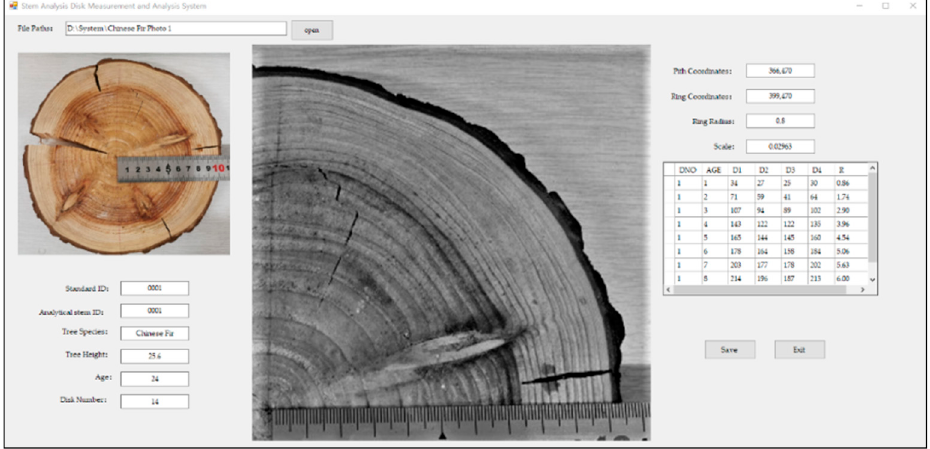
Figure 12. The main interface of the measurement and analysis system of the stem analysis disk.